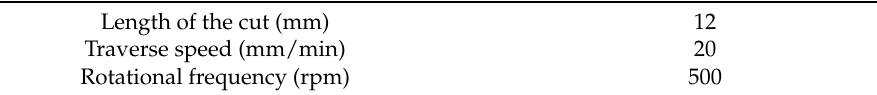
Table 6. Experimental setup with different lateral jet shifts.